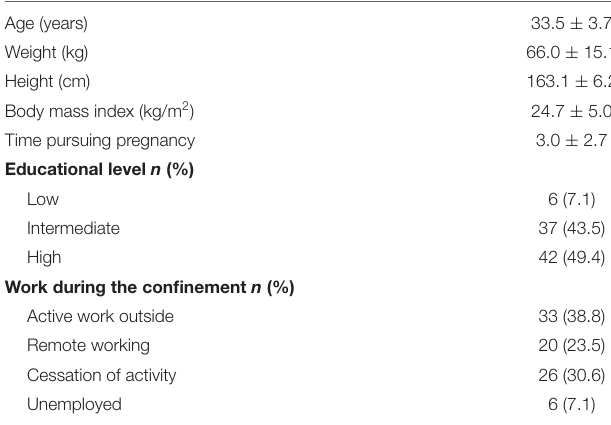
TABLE 1 | Participants’ general